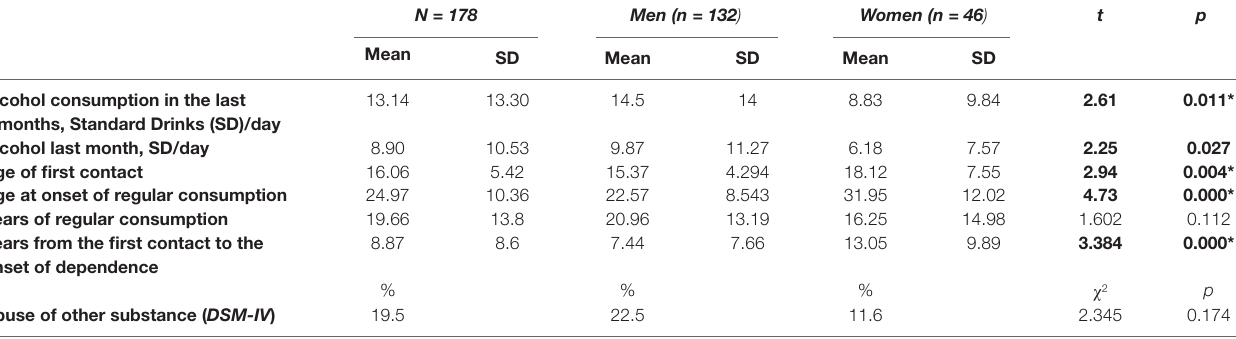
TABLE 2 | Alcohol consumption chronologic